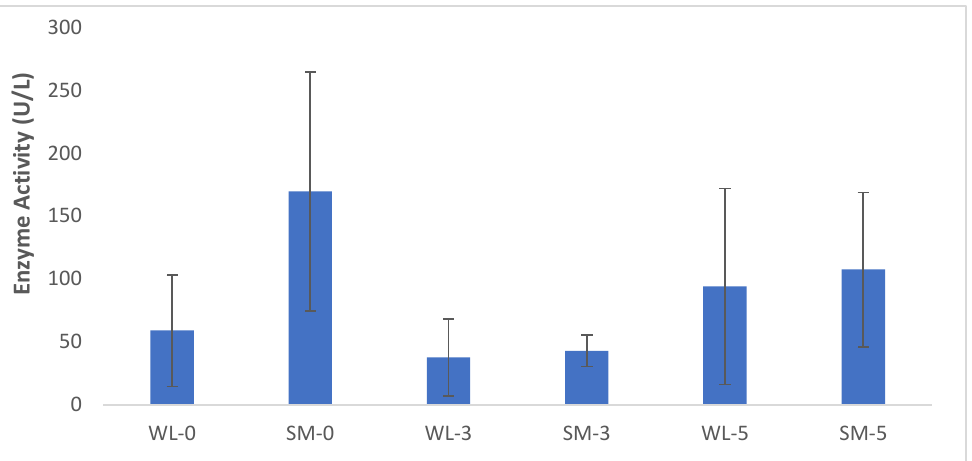
T. fruticosum (Figure 1). The activity of α -amylase activity increased significantly ( p < 0.05) throughout the five-days fermentation of the leaves of S. monostachyus and T. fruticosum compared to the control, unfermented T. fruticosum (Figure 2). This suggests the use of the amylase enzyme as a possible mechanism of action for Enterococcus faecalis , which is the fermenting organism.